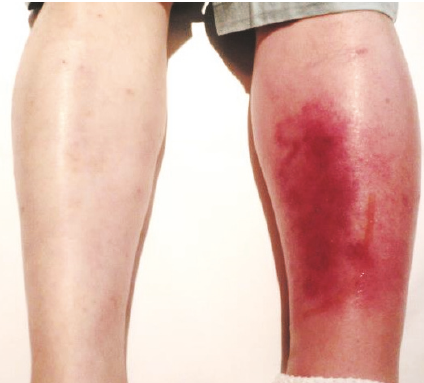
Figure 1: Photography of patient’s cellulitis: swelling and redness of his left lower